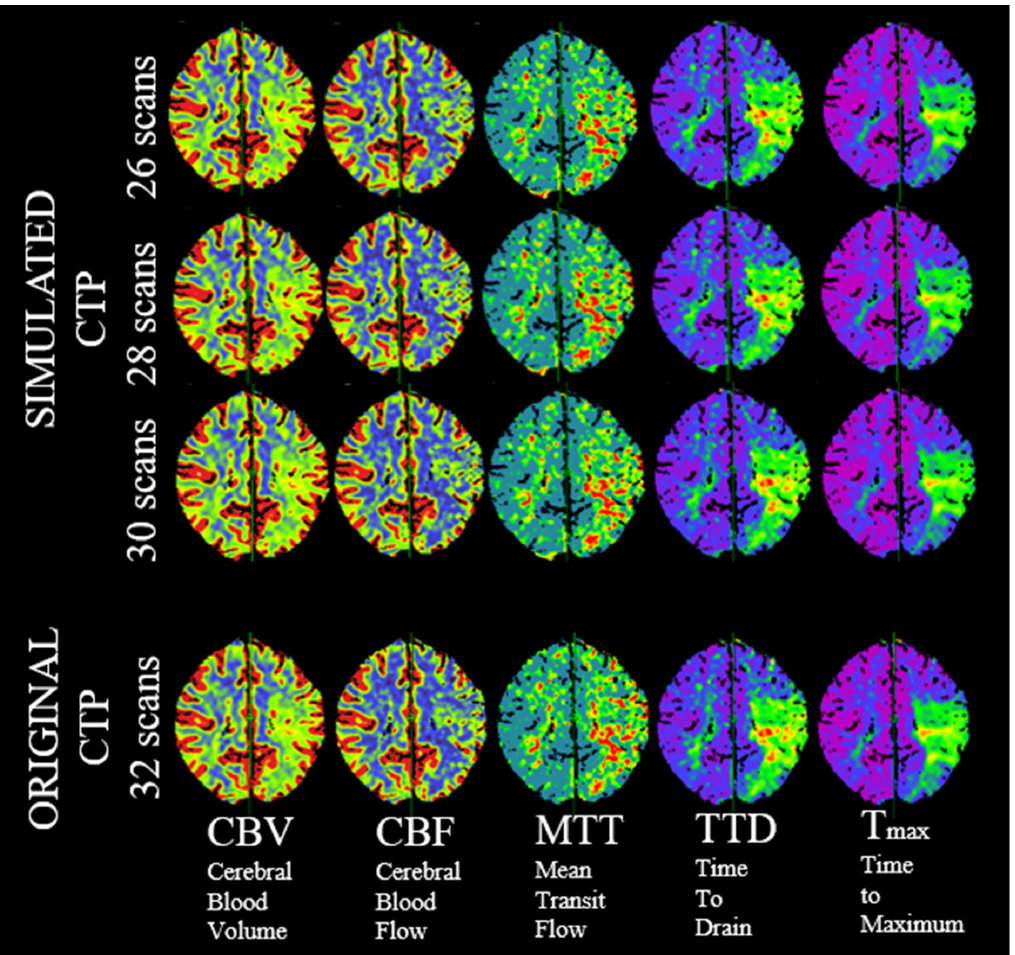
Figure 3. Visually identical perfusion maps of the original and the simulated examinations operating with 30, 28 or 26 scans.